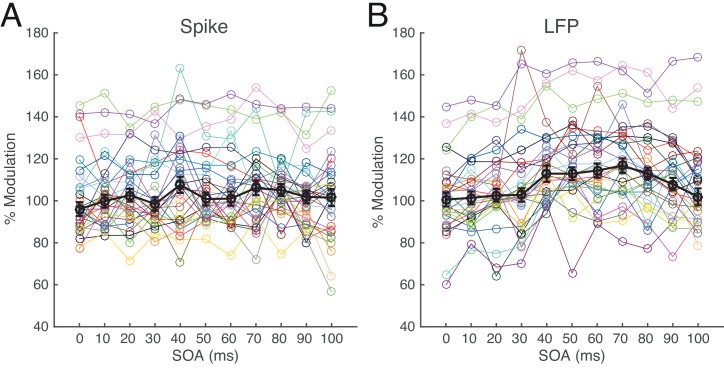
Effects of S1 on spike (A) and LFP (B) response across 11 SOA conditions.Each colored symbol represents the mean magnitude of spike (A) or LFP (B) response in percentage with respect to S2-alone condition for corresponding SOA condition of each of 30 cells for which nearest S1 was tested. Black symbols represent median values of those means with 1SEs. Percent modulations less than 100 indicate suppression and those larger than 100 indicate facilitation by addition of S1.